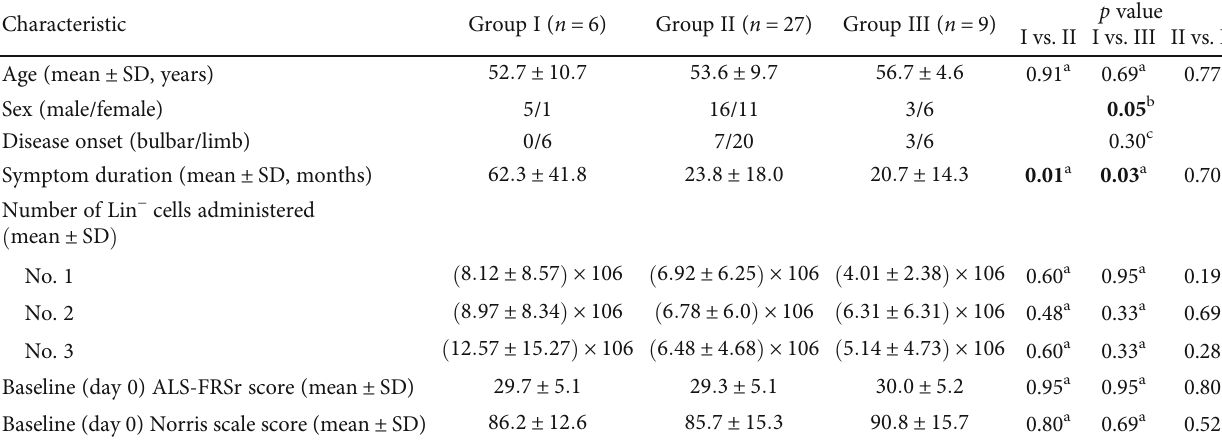
Table 1: Clinical characteristic of the study groups.